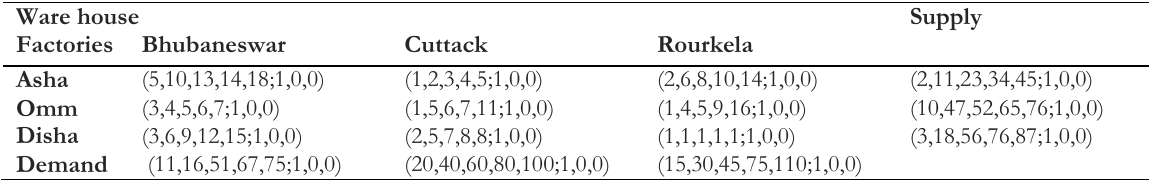
Table 2. Cost of unit for pentagonal Neutrosophic transportation